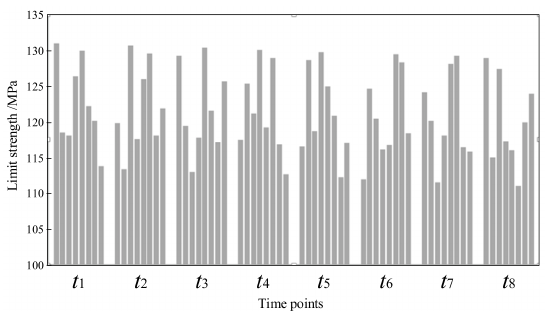
Figure A1. The distribution of limit strength at different time under 3 m/s.